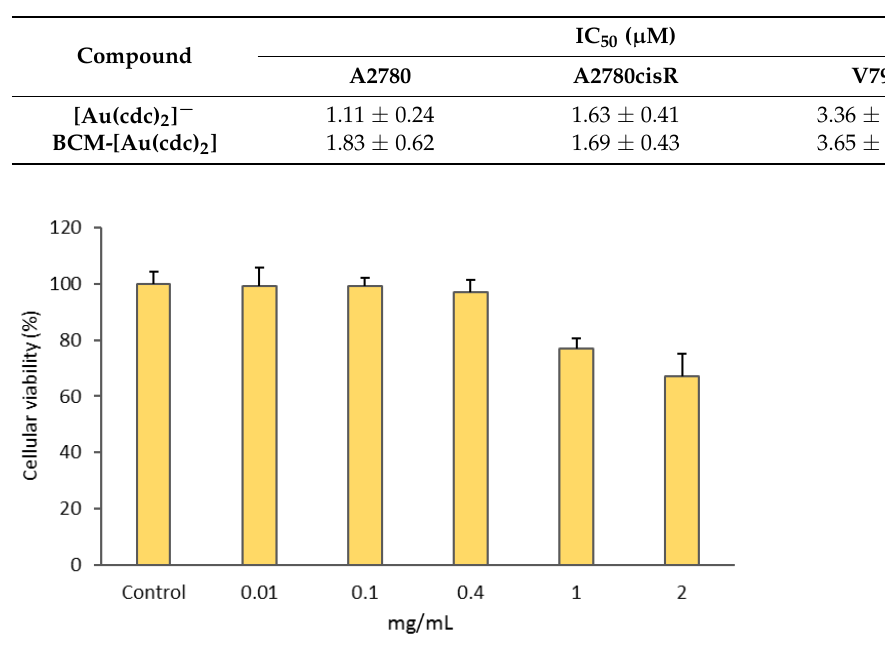
Figure 6. Cellular viabilities of A2780 cells after incubation with BCMs (unloaded micelles) for 48 h. Results shown are the means ± SDs of at least two experiments performed with six replicates each.